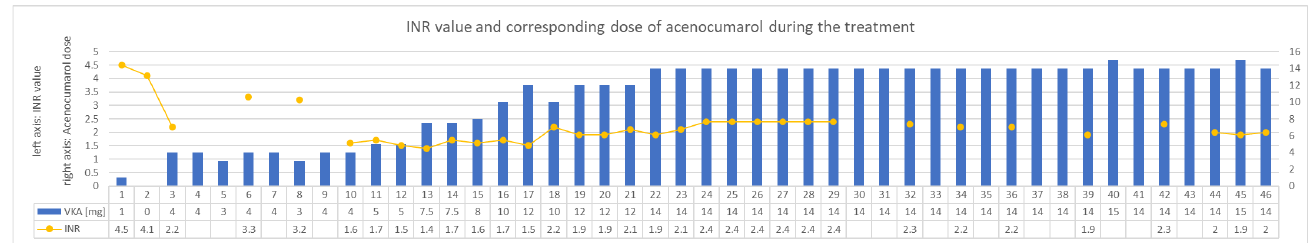
Figure 1. INR values and treatment in following days of concomitant administration of acenocumarol and rifampicin—case INR – international normalized ratio. VKA- vitamin K antagonist. 1. INR—international normalized ratio. VKA—vitamin K